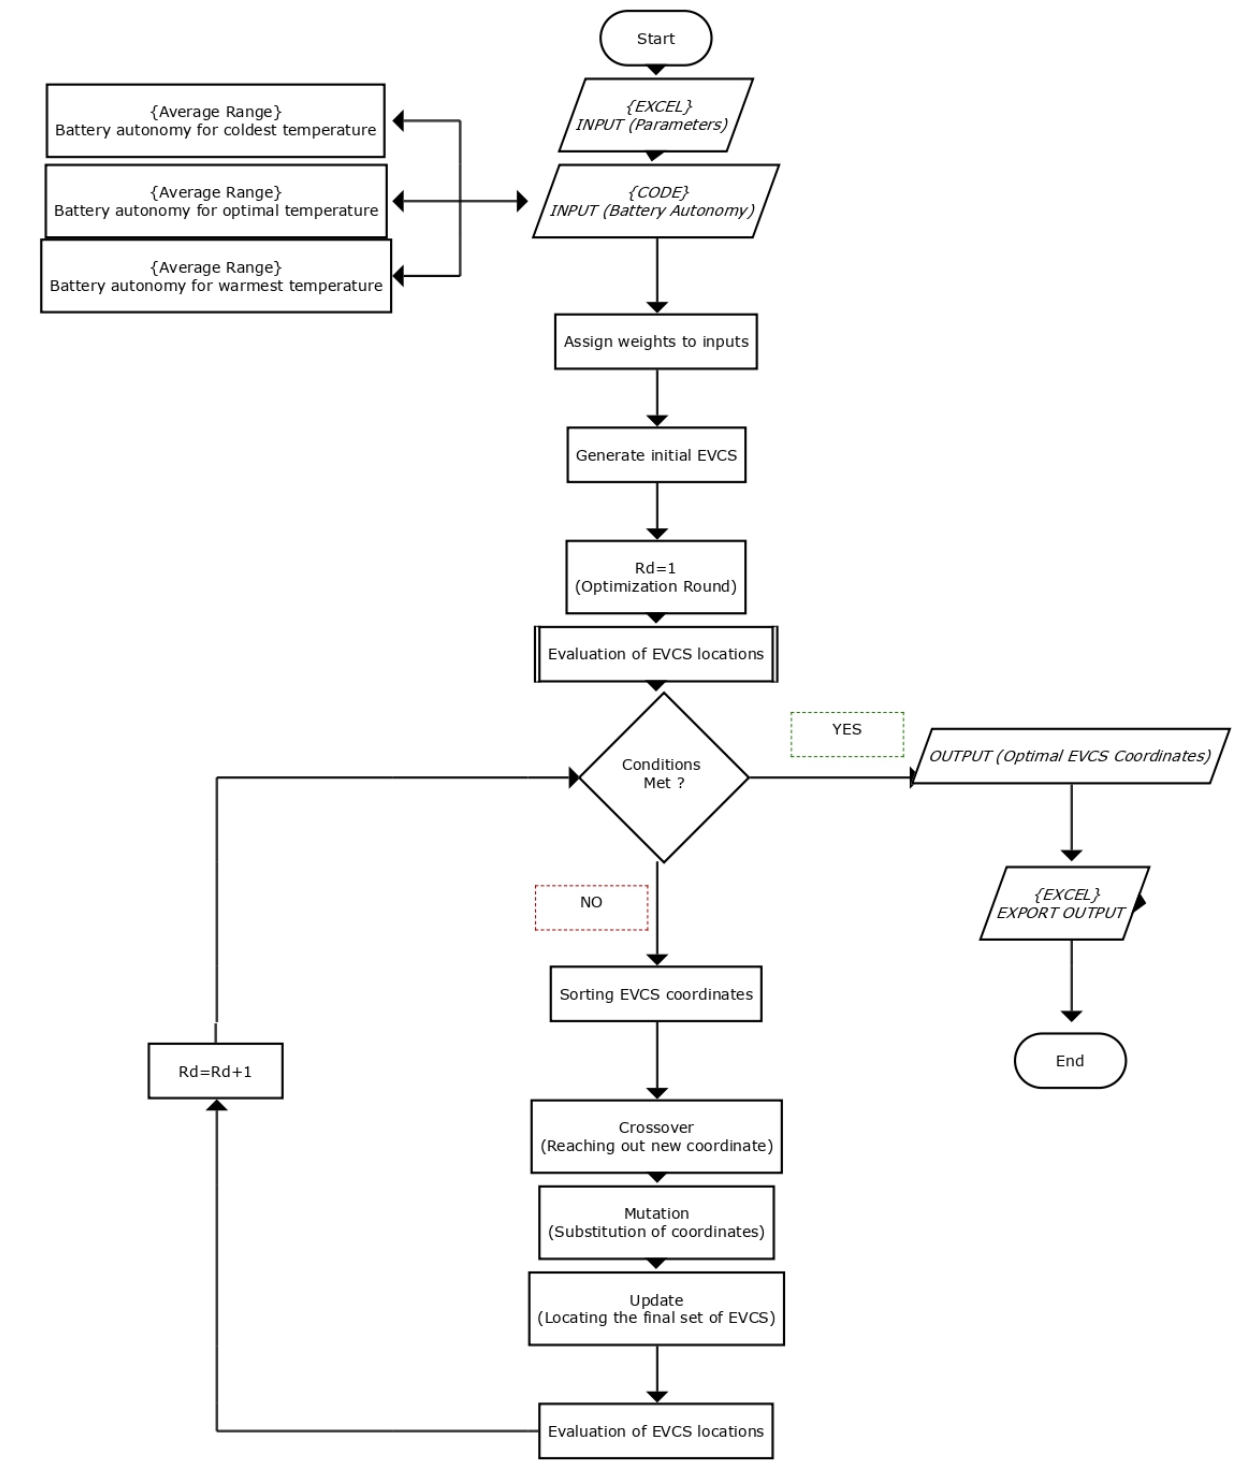
Figure 7. Genetic Algorithm for the Paper. The model imports input parameters, listed in Figure 1, from an Excel file. Battery autonomy is also imported, but each time the model imports one range of the three. Eventually, weights are assigned to inputs manually based on the impact of the input. The code, then, generates an initial list of EVCS given the input parameters and assigned weights. The generated list shall undergo a test of conditions (Equations (3)–(5)),